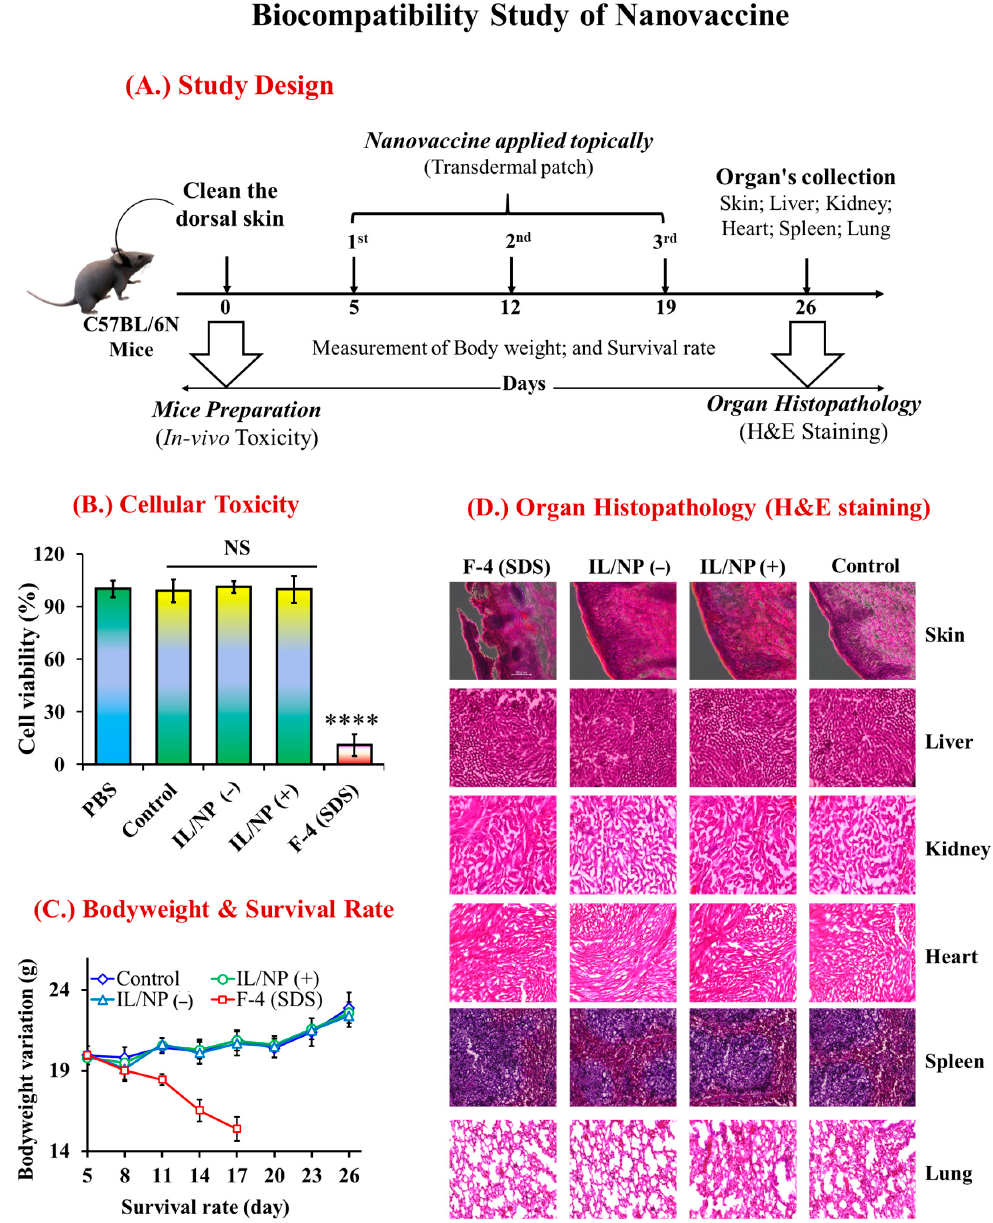
Figure 8. Biocompatibility study of the nanovaccine. ( A ) A schematic representation of the in vivo